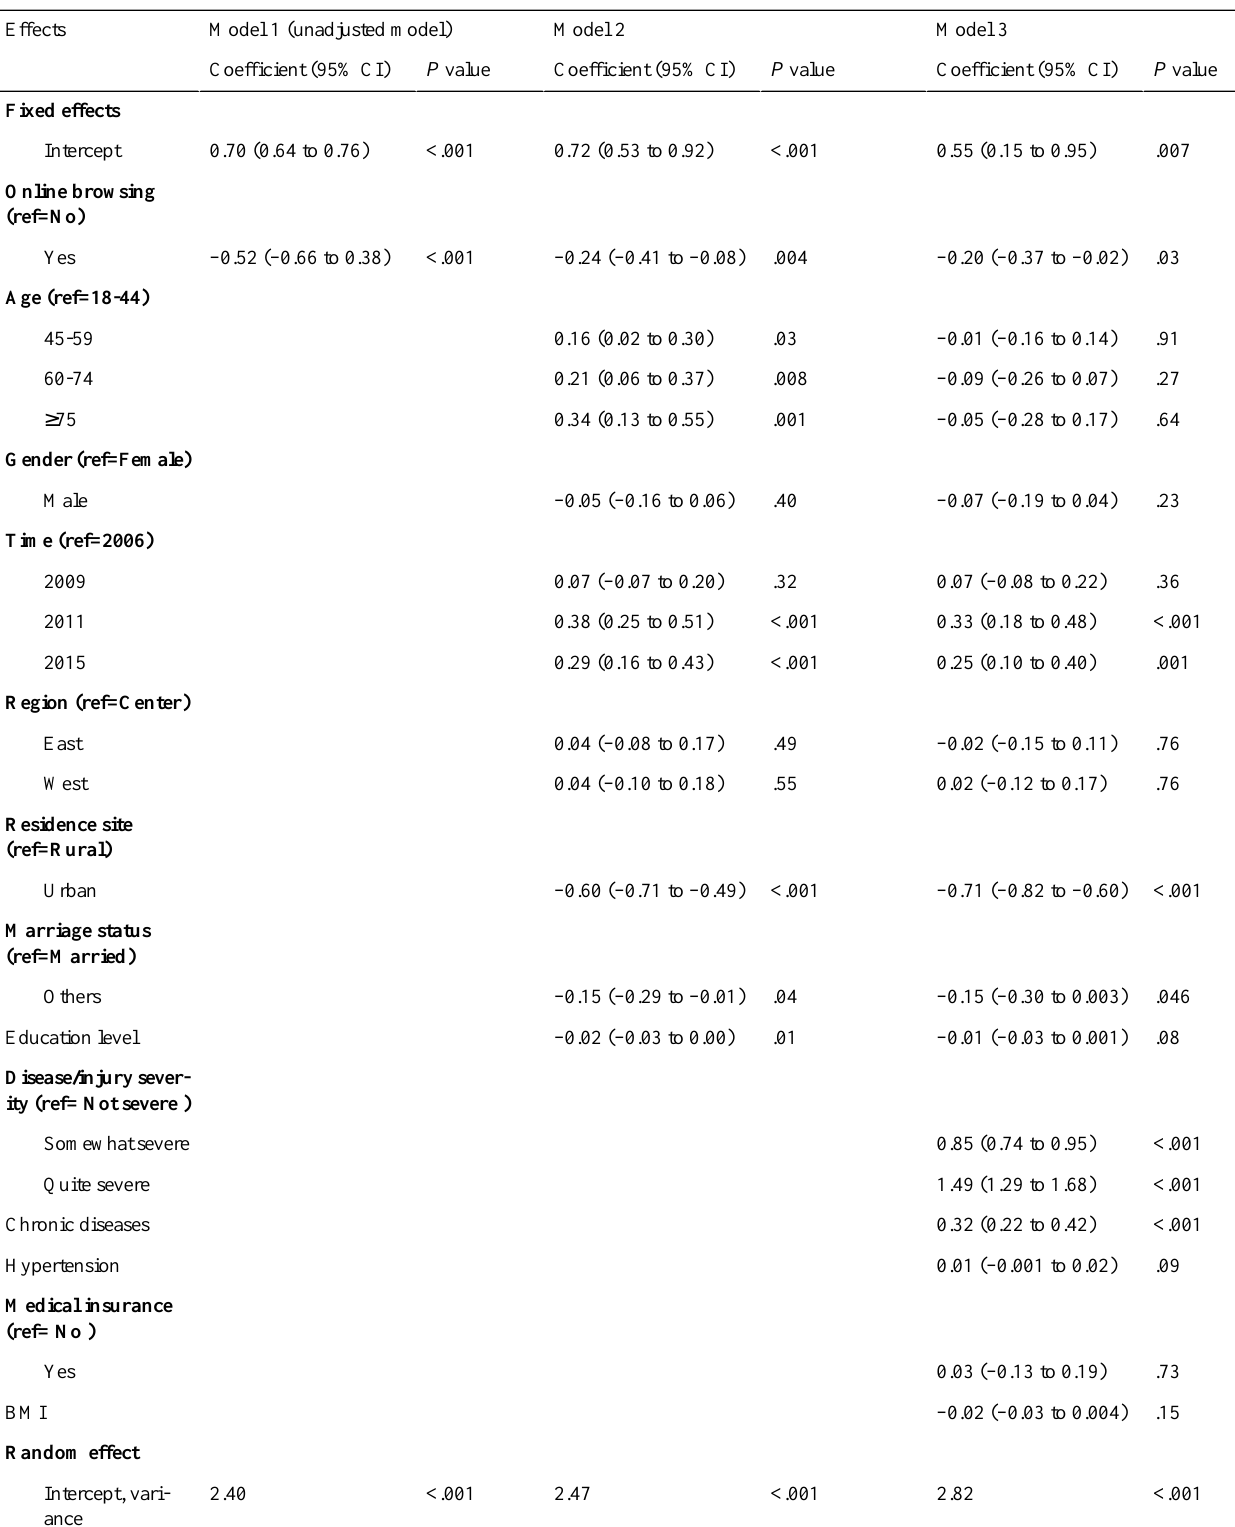
Table 5. Results of a generalized linear mixed-effects binomial logit model analyzing the influence of internet use on choosing self-care versus hospital